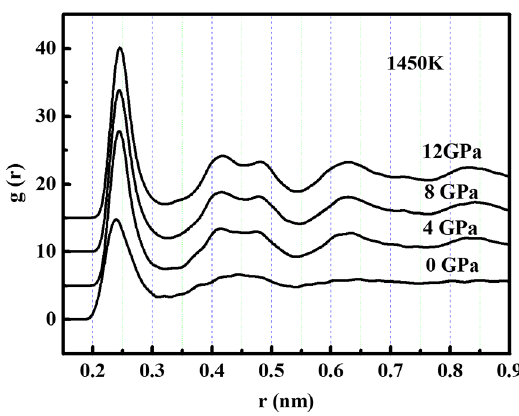
Figure 1. The PDF of iron under different pressures at 1450K.